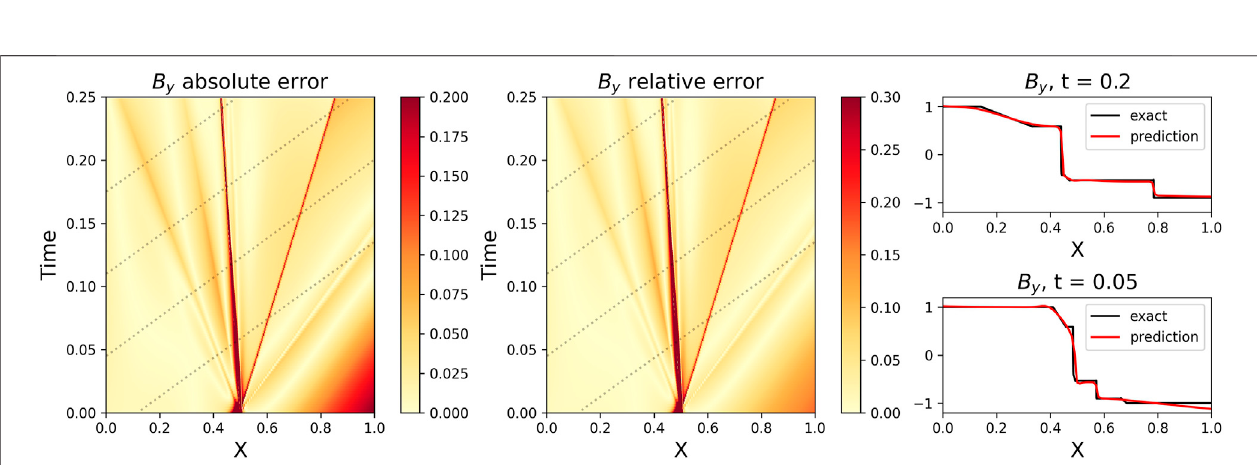
FIGURE 11 | Same as Figure 10 , except plotting both the B y absolute error (cid:3) B y , net − B y (cid:3) and the B y relative error (cid:3) ( B y , net − B y )/ B y (cid:3) , and B y at selected times. Random Gaussian noise (c.f. Figure 9 ) has been added to the data.